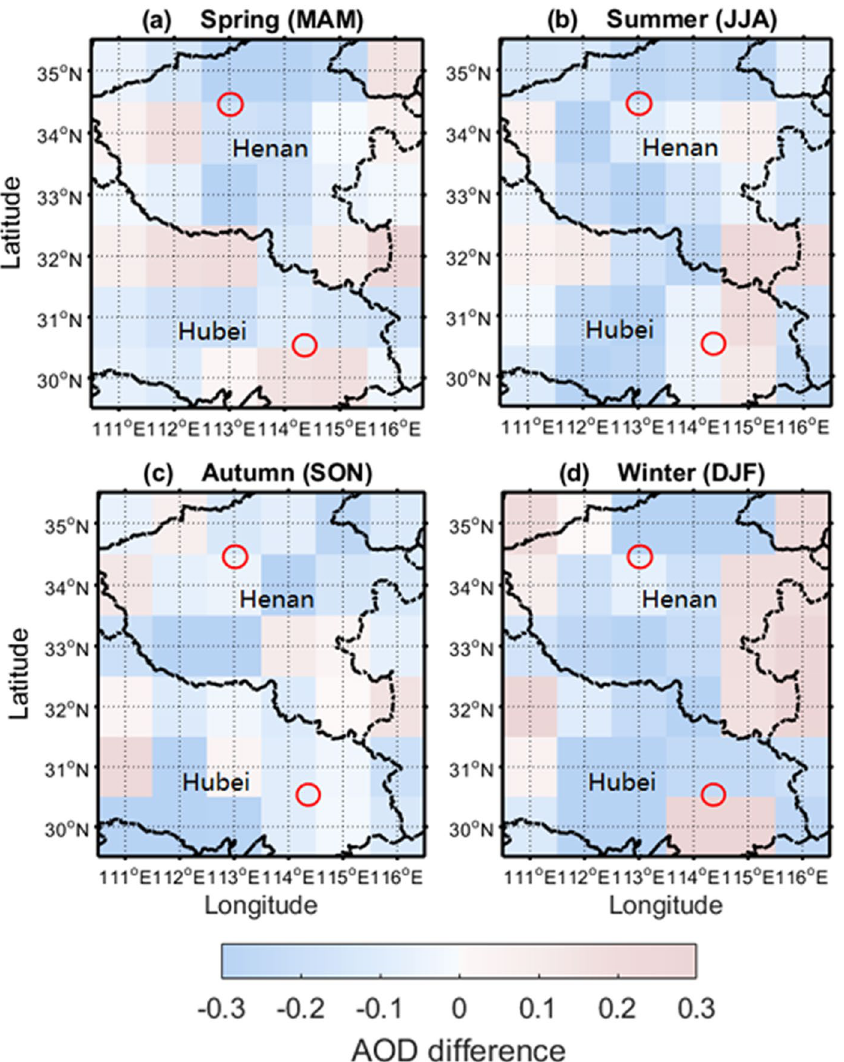
Figure 6. Seasonal mean differences of MYD_DB and CALIPSO AODs from November 2013 to December 2017 on 1° × 1° equal-angle grids. Red circle represents the ground-based observation station. ( a ) Spring: March, April, May; ( b ) summer: June, July, August; ( c ) autumn: September, October, November; ( d ) winter: December, January,